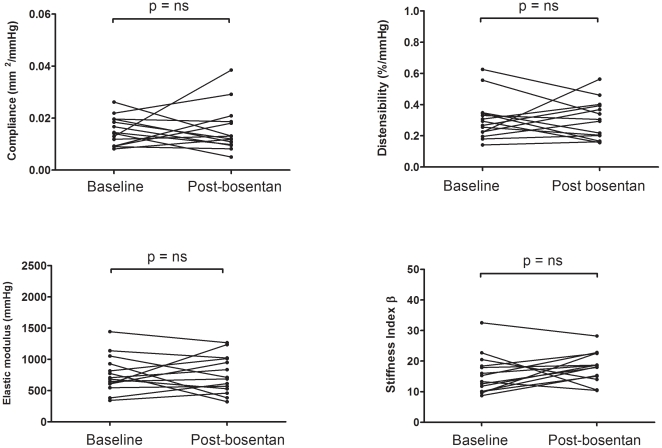
Individual data points of PA stiffness measurements before and after 6-months of therapy with bosentan in PAH subjects (n = 14).Bosentan therapy was associated with no significant changes in PA stiffness indices: compliance (1.51±0.15×10–2 mm2/mmHg at baseline vs 1.56±0.15×10–2 mm2/mmHg at 6 months, p = 0.86), distensibility (0.31±0.04%/mmHg at baseline vs 0.30±0.03%/mmHg at 6 months, p = 0.92), elastic modulus (763±80 mmHg at baseline vs 756±81 mmHg at 6 months, p = 0.94), and stiffness index β (15.7±1.7 at baseline vs 18.1±1.3 at 6 months, p = 0.198). Data expressed as mean±SEM.